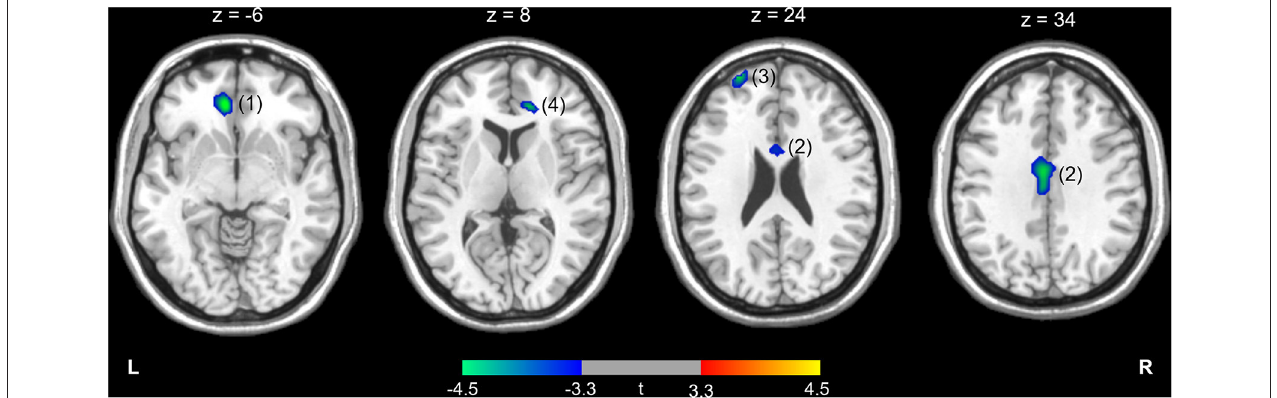
FIGURE 1 | Higher (red-yellow) or lower (blue-green) regional cerebral metabolic rate of glucose in participants with Internet gaming disorder compared with controls. The numbers above the brain slices indicate z coordinates in the Montreal Neurological Institute space. The color bar represents t value at each voxel. The numbers in parentheses show the cluster numbers listed in Table 2 . L, left; R, right.